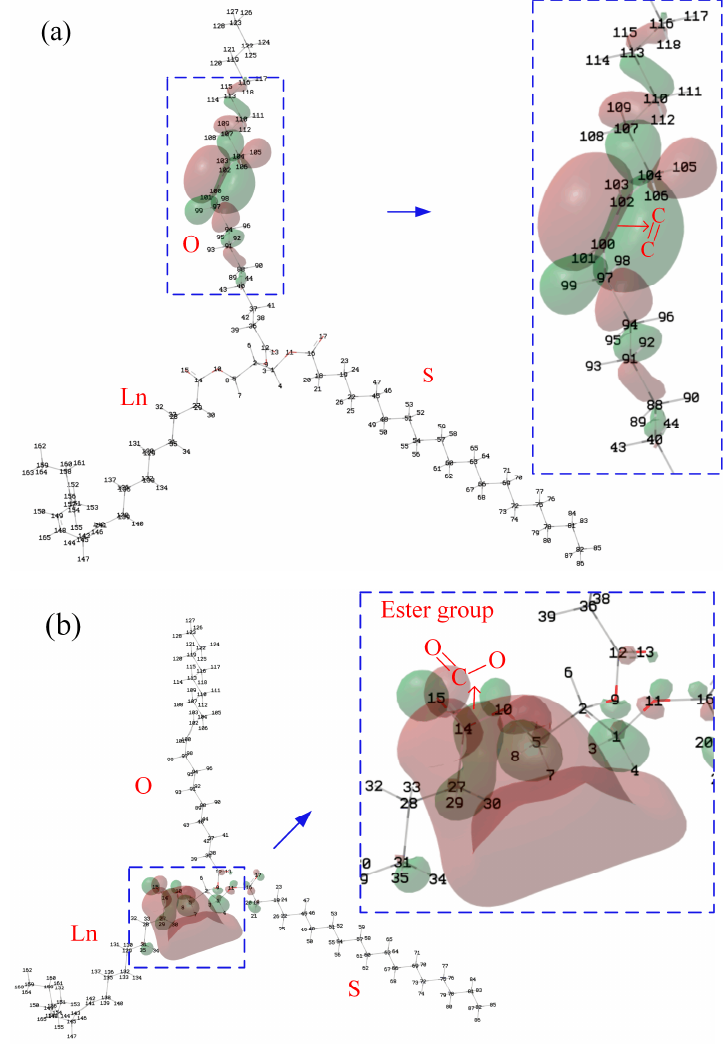
Figure 4. Isosurface of the HOMO and LUMO of N-OSLn: ( a ) HOMO; ( b ) LUMO.